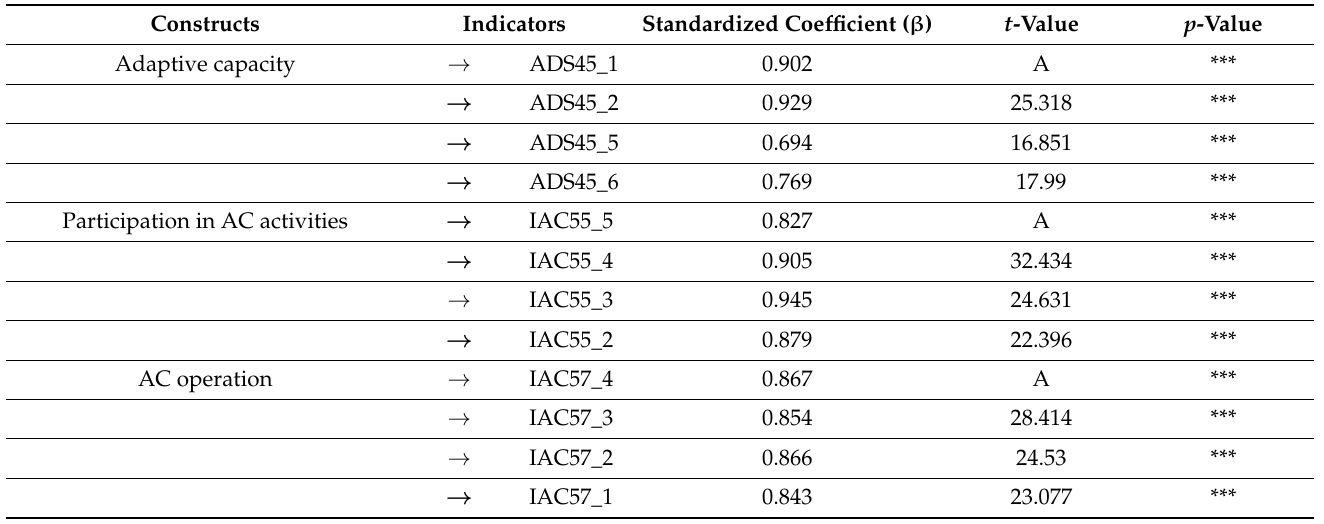
Table 5. The results of